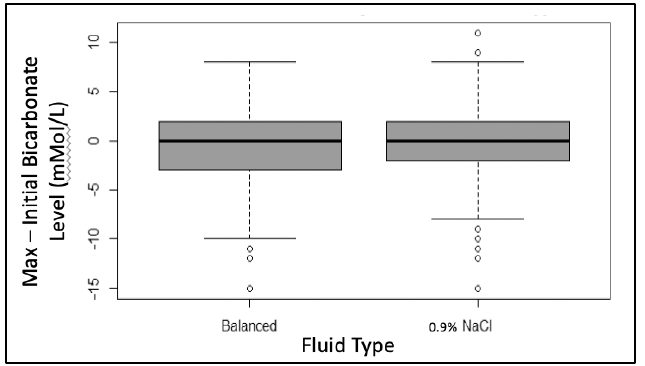
Figure 3. Comparison of the change in serum bicarbonate level by subtracting the minimum bicar- bonate level from the initial bicarbonate level in the first 72 h of admission. There was no difference in the decrease in bicarbonate levels between the two groups, p = 0.830.